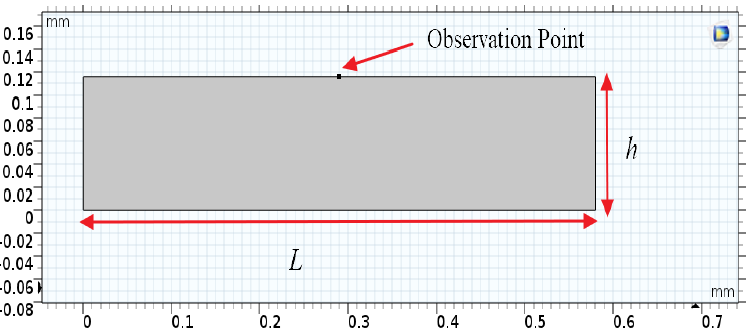
Figure 4. The water tank design is settled in the COMSOL environment. The water tank size: the width L is 580 μ m, and the depth h is 116 μ m.